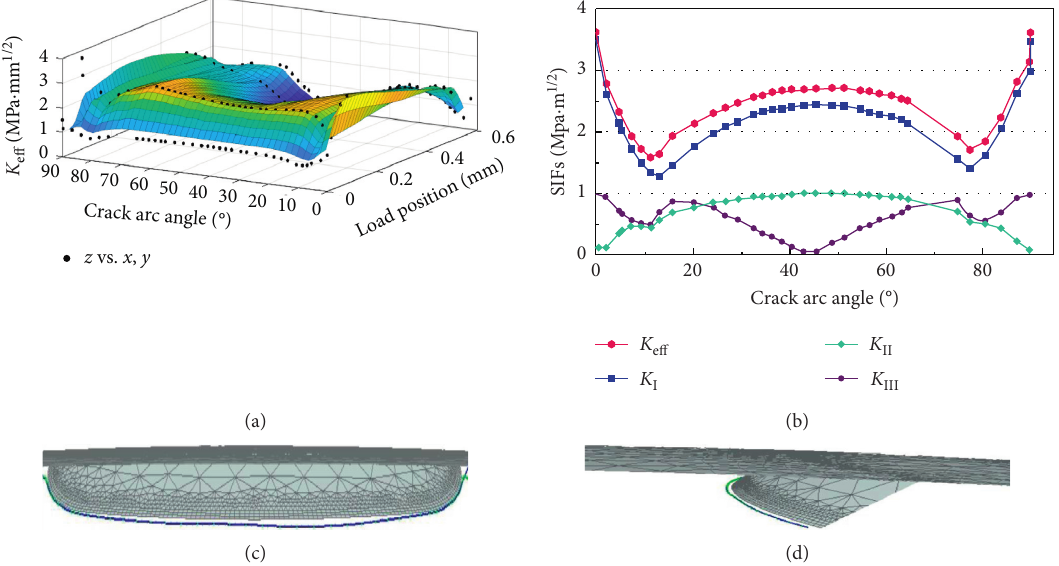
Figure 16: Related results for crack III: (a) K eff at different positions; (b) calculation of the SIFs when the load position is 0.5mm; (c) front view of crack propagation; (d) side view of crack